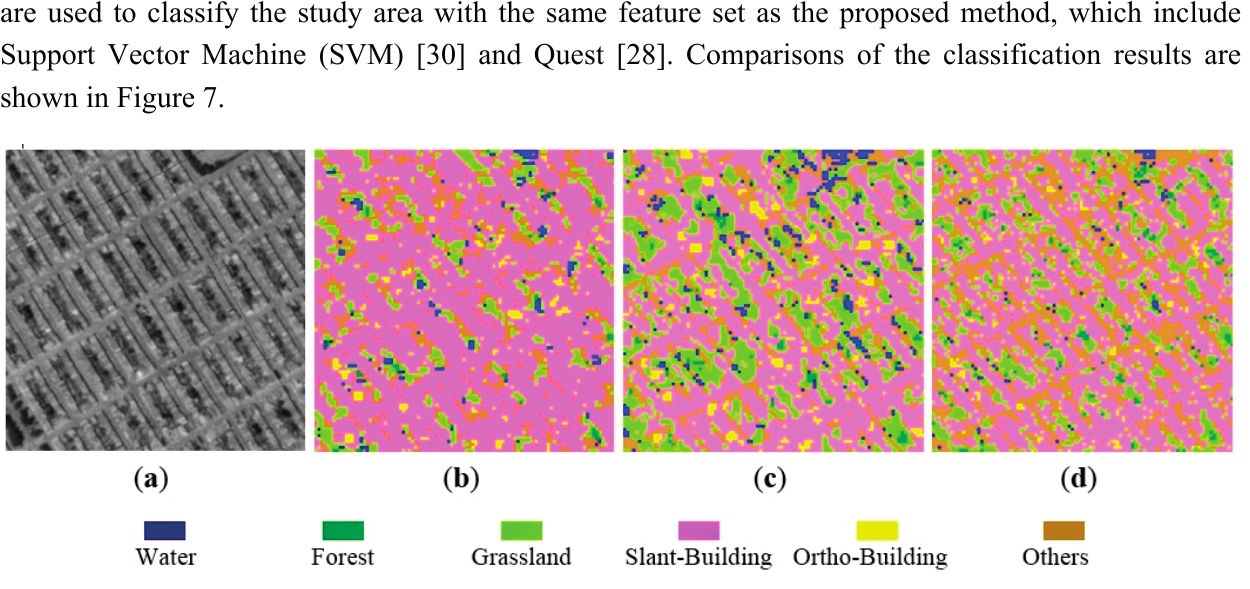
Figure 7. Details of the Classification Results. ( a ) Ground truth; ( b ) Support Vector Machine (SVM); ( c ) Quest; ( d ) proposed